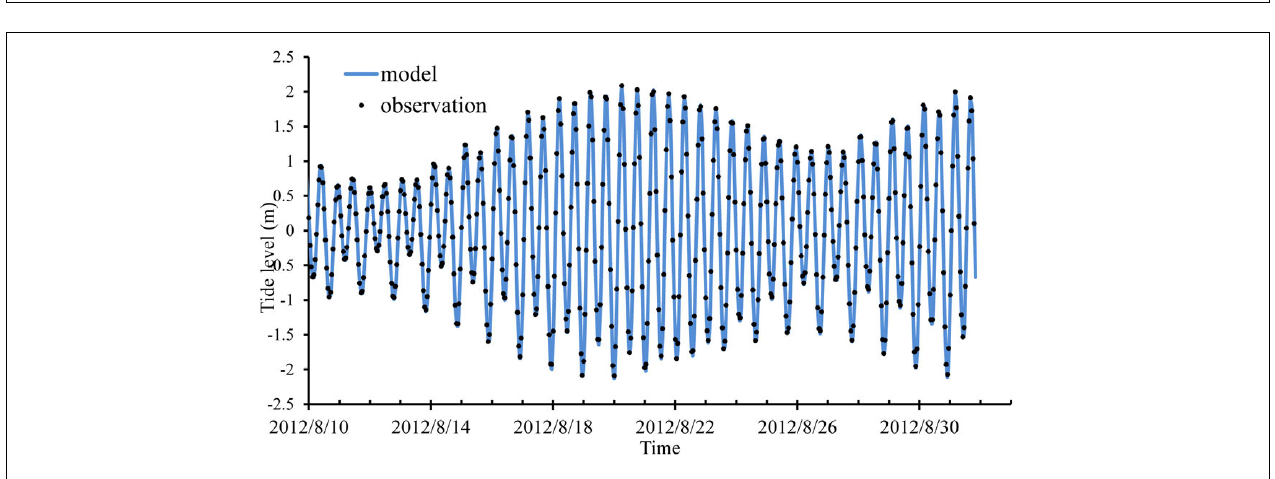
FIGURE 3 | Tidal level comparison between model results and measured data at Station